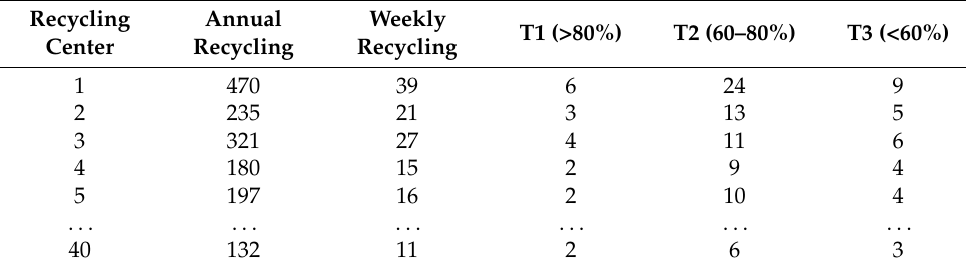
Table 1. Recycling volume of each recycling center.